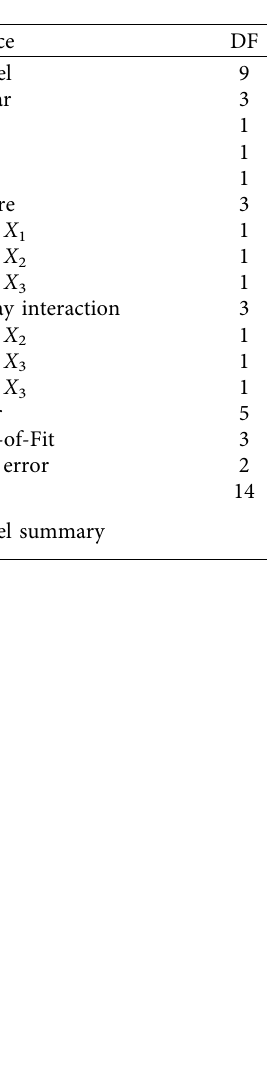
Table 4: Analysis of variance for production of